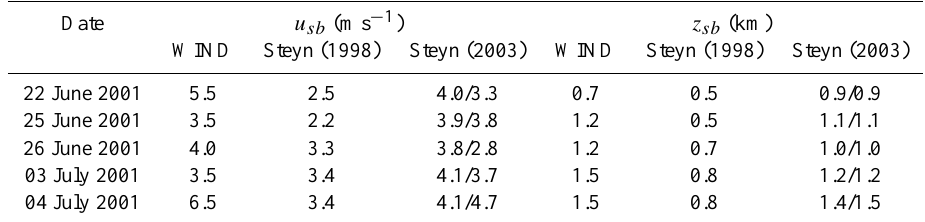
Table 3. Measured and predicted values [from Steyn scaling analysis] of the speed and depth of the documented sea breeze events near the